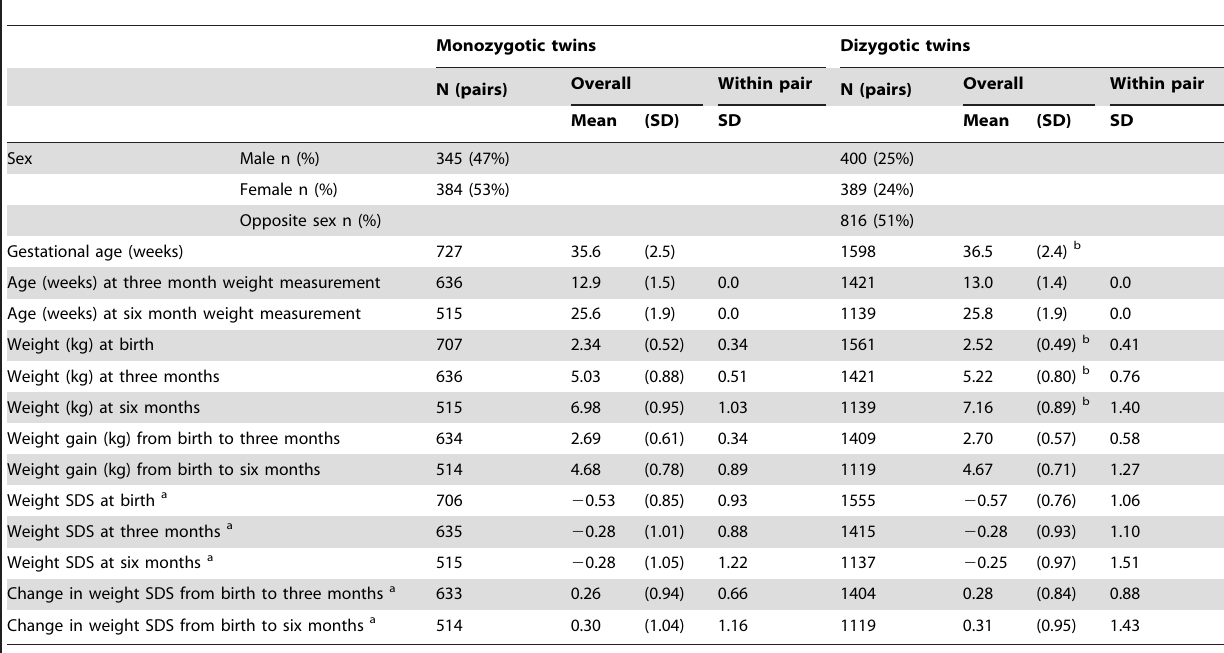
Table 1. Descriptive statistics of weight and weight change in infancy in the Gemini cohort.